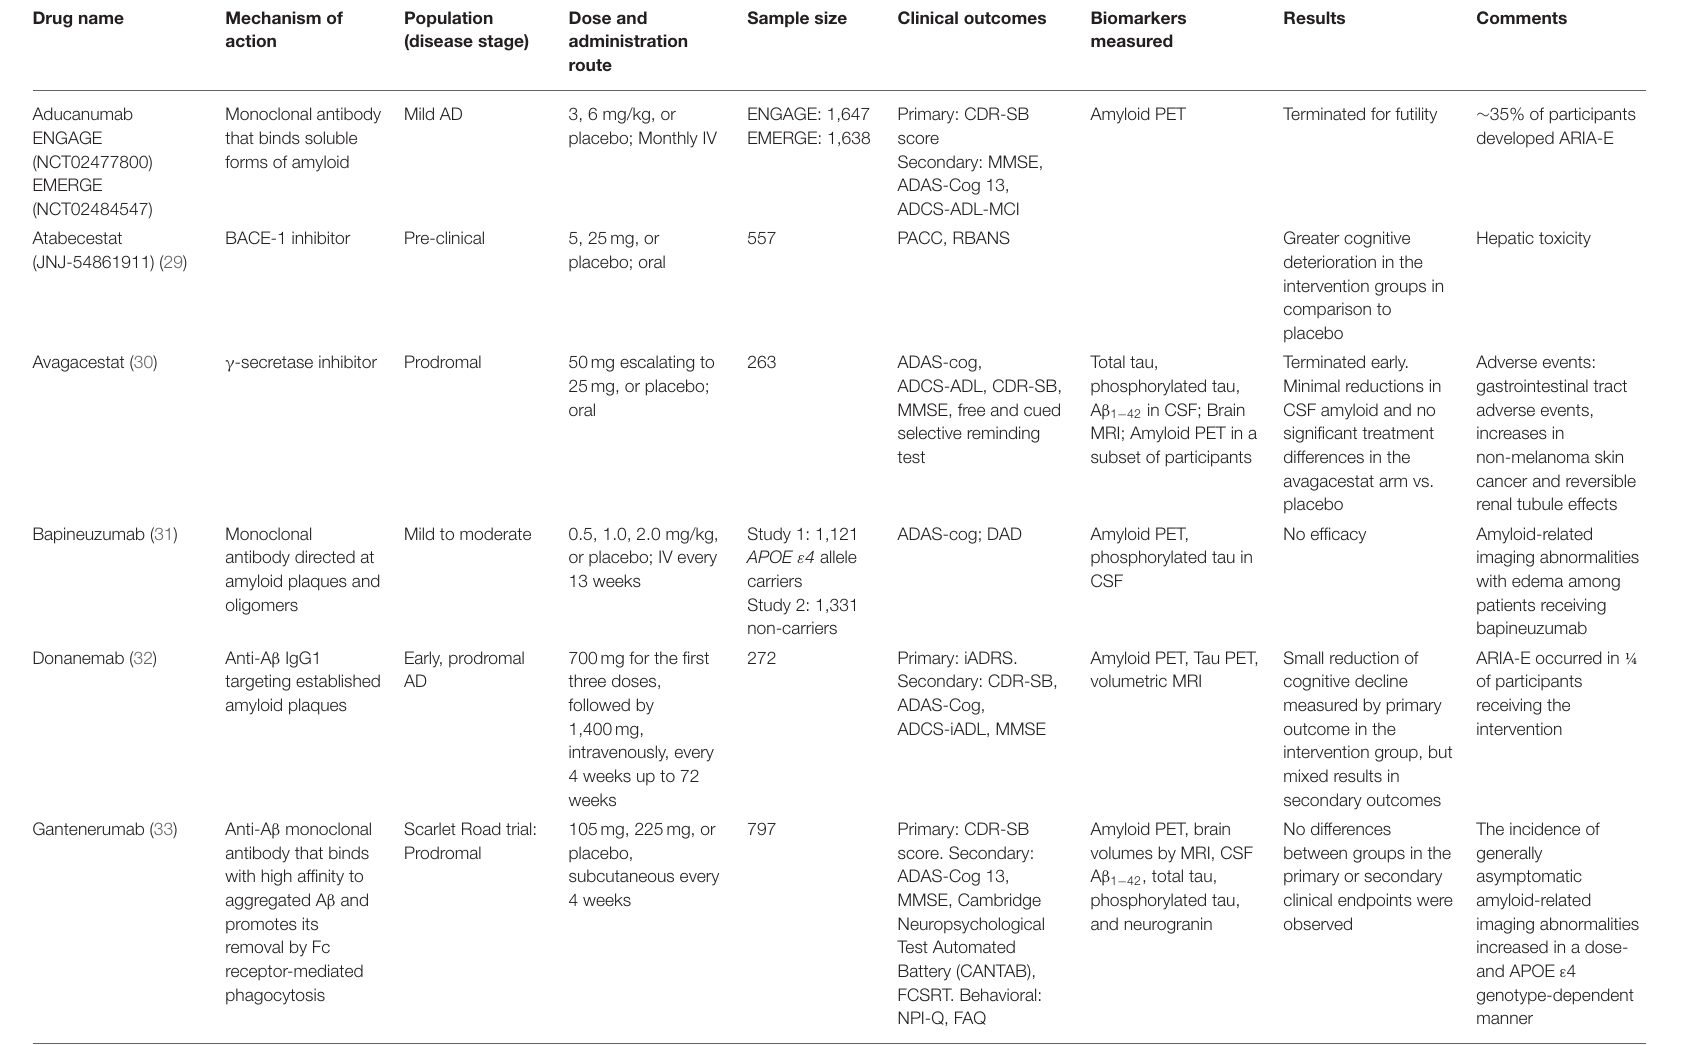
TABLE 1 | Recent clinical trials for disease-modification in